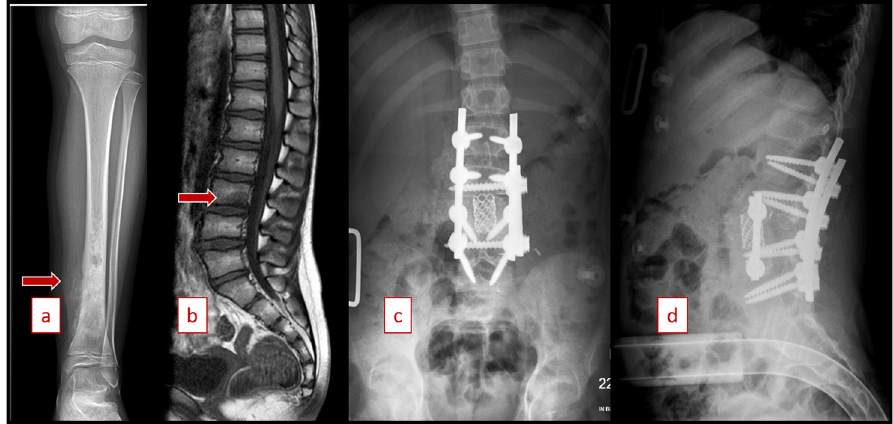
Figure 1. (a) AP view of primary osteosarcoma of left tibia (February 2016). (b) T1 SAG of lumbar spine with metastatic lesion involving vertebral body of L3 (February 2016). (c) PA postoperative image following initial en bloc resection with L3 corpectomy (March 2016). (d) Lateral postoperative image following initial en bloc resection with L3 corpectomy (March 2016).